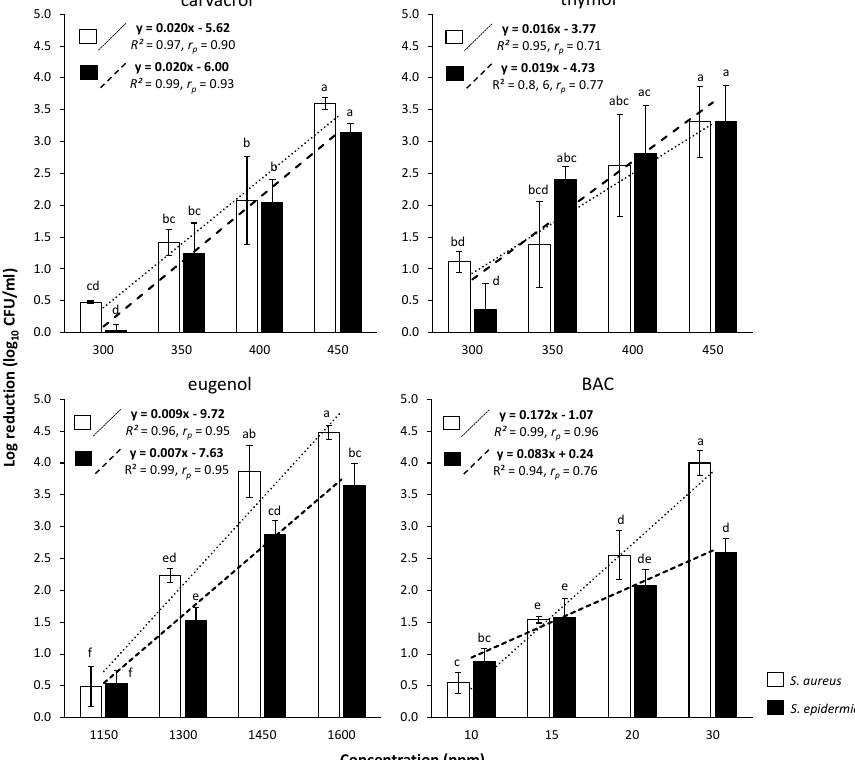
Figure 2. Log reductions (log 10 CFU / mL) of planktonic cells for each bacterial species ( (cid:3) S. aureus ; (cid:4) S. epidermidis ) following 6 min exposure to each compound (i.e., CAR, THY, EUG, and BAC) applied at four different concentrations (ppm). The bars represent the mean values ± standard deviations. For each separate graph, mean values sharing at least one common letter shown above the bars are not significantly different ( p > 0.05). Dotted lines illustrate linear regression correlations between the log reductions achieved (for each species) at each tested compound’s concentration. The mathematical equations of these regression plots, together with their regression coefficients ( R 2 ) and Pearson’s correlation coefficients ( r p ), are also shown.